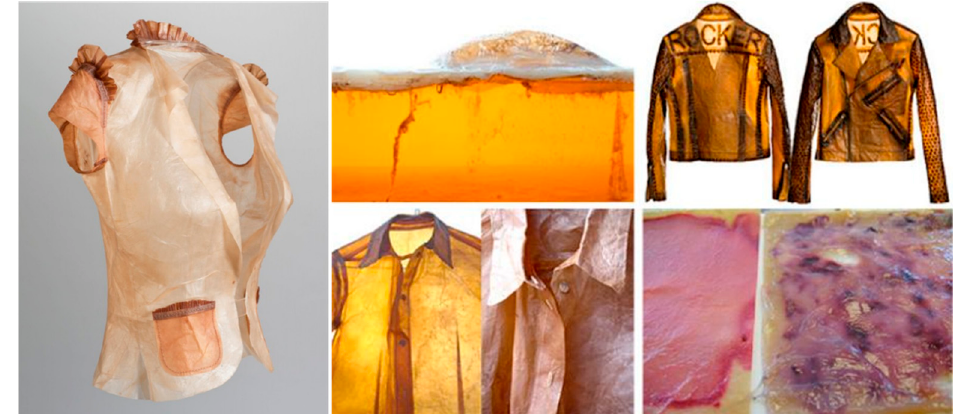
Figure 12. BioCouture using microbial cellulose, grown in a laboratory, to produce clothing [184].